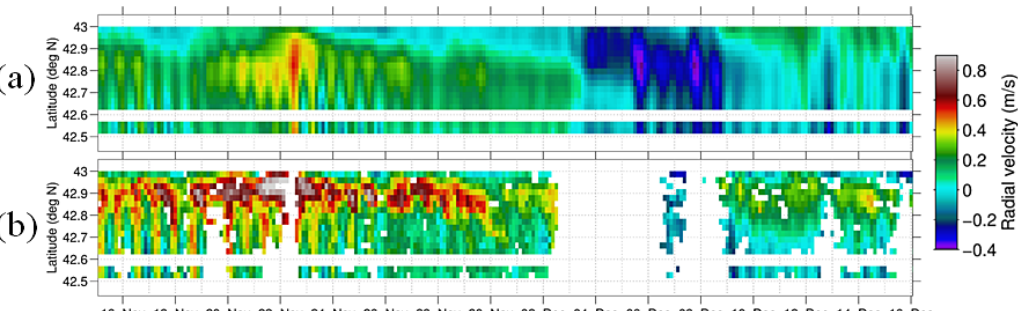
Figure 2. Hovmöller diagram of radial velocities from the PEY station along a south–north transect at 6.2 ◦ N (see Fig. 1), (a) from free simulation and (b) from